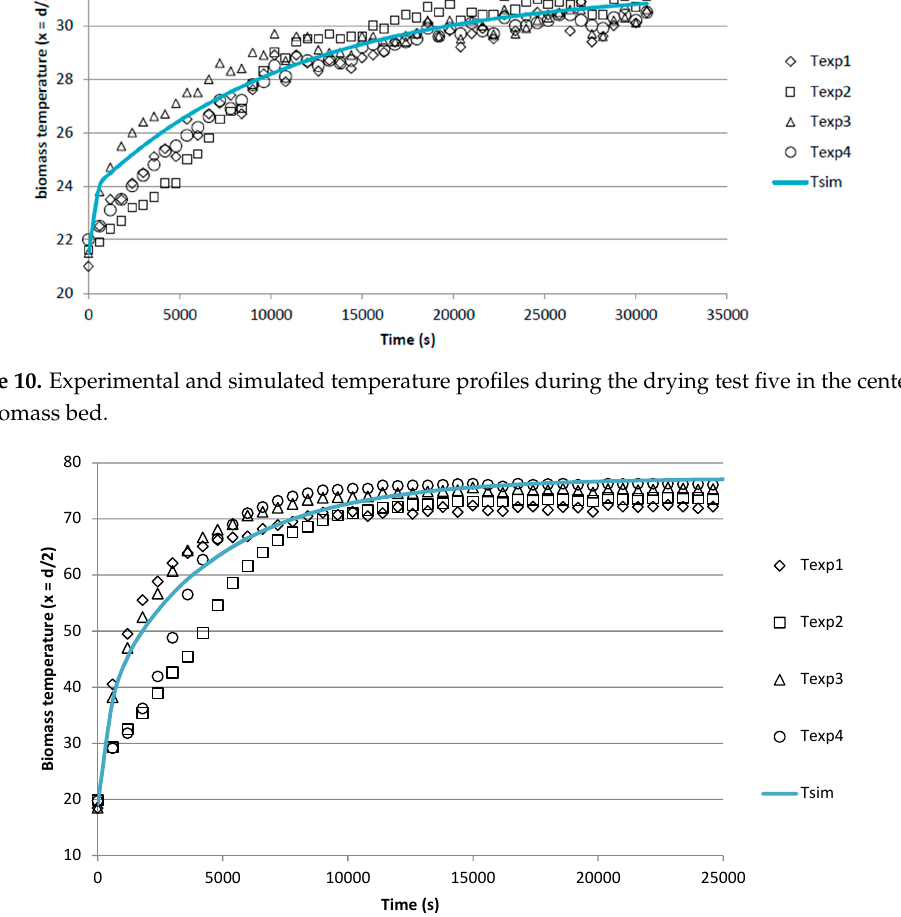
Figure 11. Experimental and simulated temperature profiles during the drying test six in the center of the biomass bed.